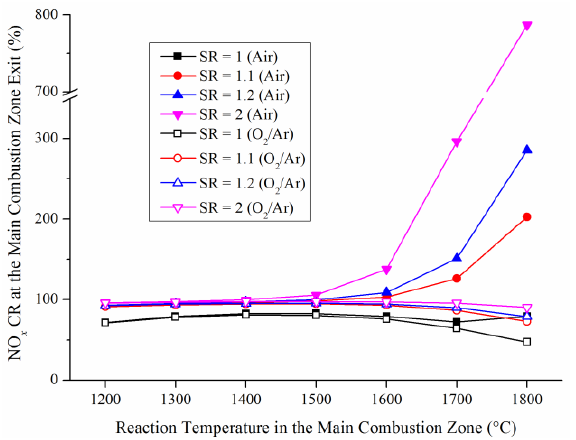
Figure 6. Comparison of NO x emissions between air combustion and O 2 / Ar combustion under oxidizing atmosphere conditions.